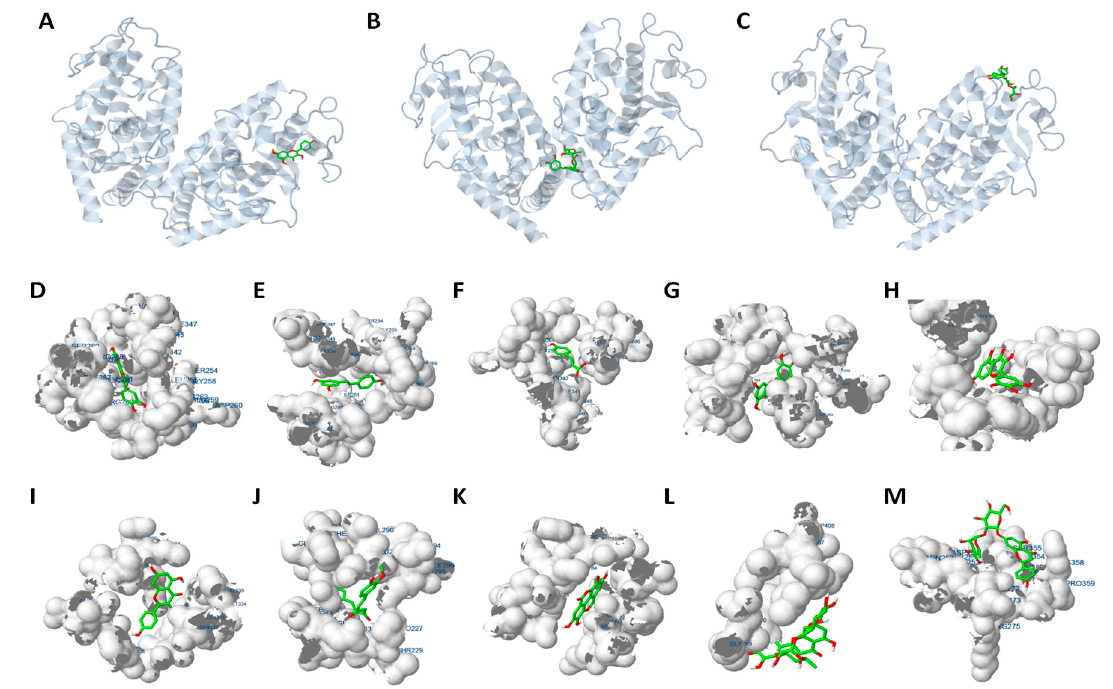
Figure 5. Representation of the specific interaction of different phenolic compounds with PPAR γ . ( A – C ) Location of the PPAR γ binding site for quercetin ( A ), hesperidin ( B ) and naringin ( C ). PPAR γ structure (grey) is represented in cartoon and phenolic compounds (green and red) as bonded. ( D – M ) Closer view of phenolic compounds (bonded) interaction with the PPAR γ ligand-binding domain (LBD, represented as electronic cloud surface, grey). Interaction with the LBD of quercetin ( D ), resveratrol ( E ), p-coumaric acid ( F ), luteolin ( G ), myricetin ( H ), kaempferol ( I ), curcumin ( J ), ellagic acid ( K ), hesperidin ( L ) and naringin ( M ).